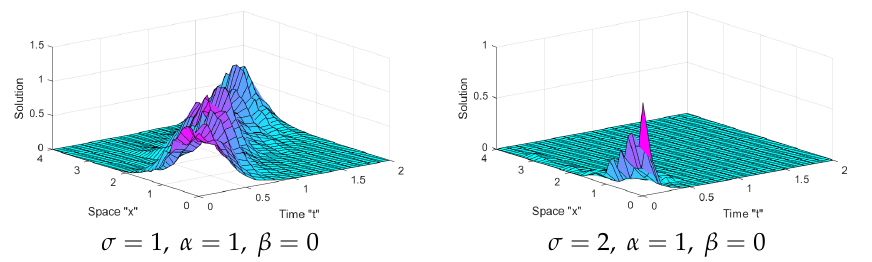
Figure 3. A 3D-plot of the solution ϕ ( x , t ) in Equation (26) for σ = 1,2.